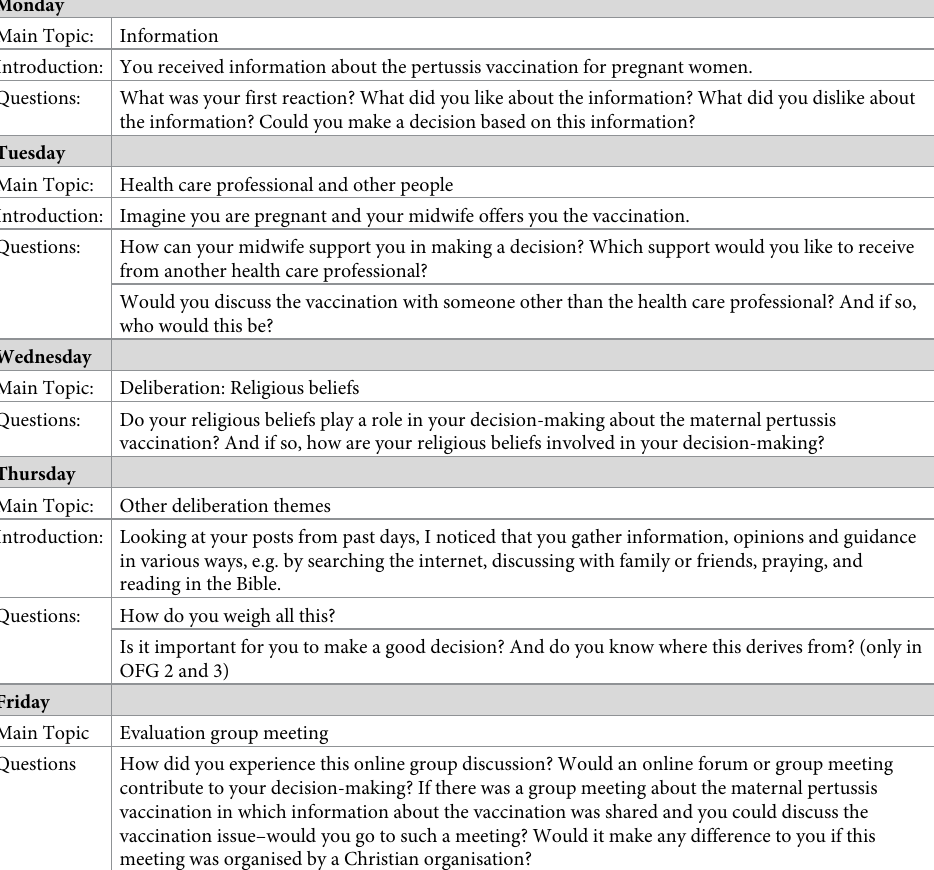
Table 2. Online focus group topic